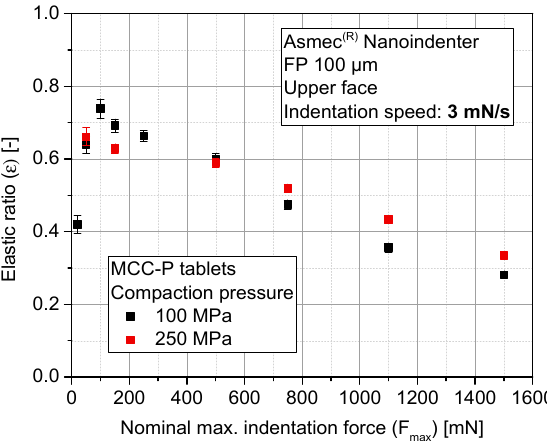
Figure 10. Elastic ratio ( ε ) of MCC-P tablets as a function of the maximum indentation force for different nominal compaction pressures.